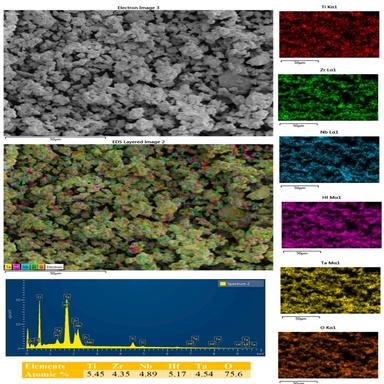
SEM image and elemental mapping of the produced HEO sample after oxidation.